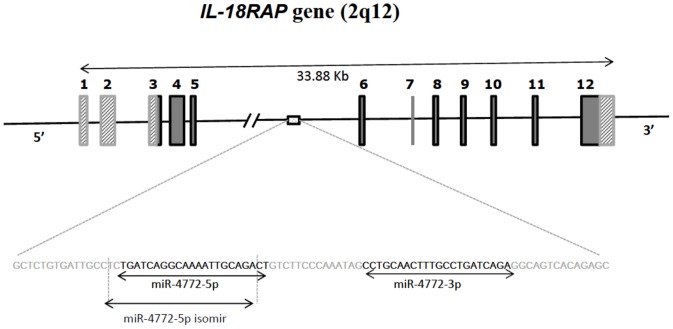
Simplified diagram illustrates the genomic location of miR-4772 family on Chromosome q12.1 within intron 5 of IL-18 RAP.